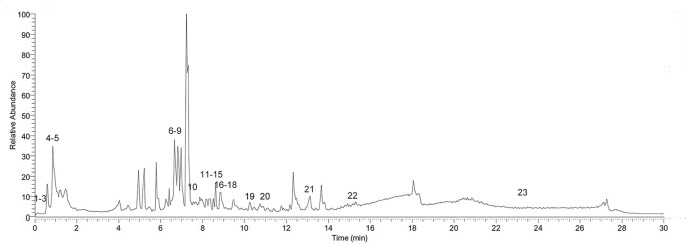
Base peak ion (BPI) chromatogram of Zi Shen Huo Luo Formula (ZSHLF) in a positive ion flow diagram obtained by UPLC-MS/MS analysis.